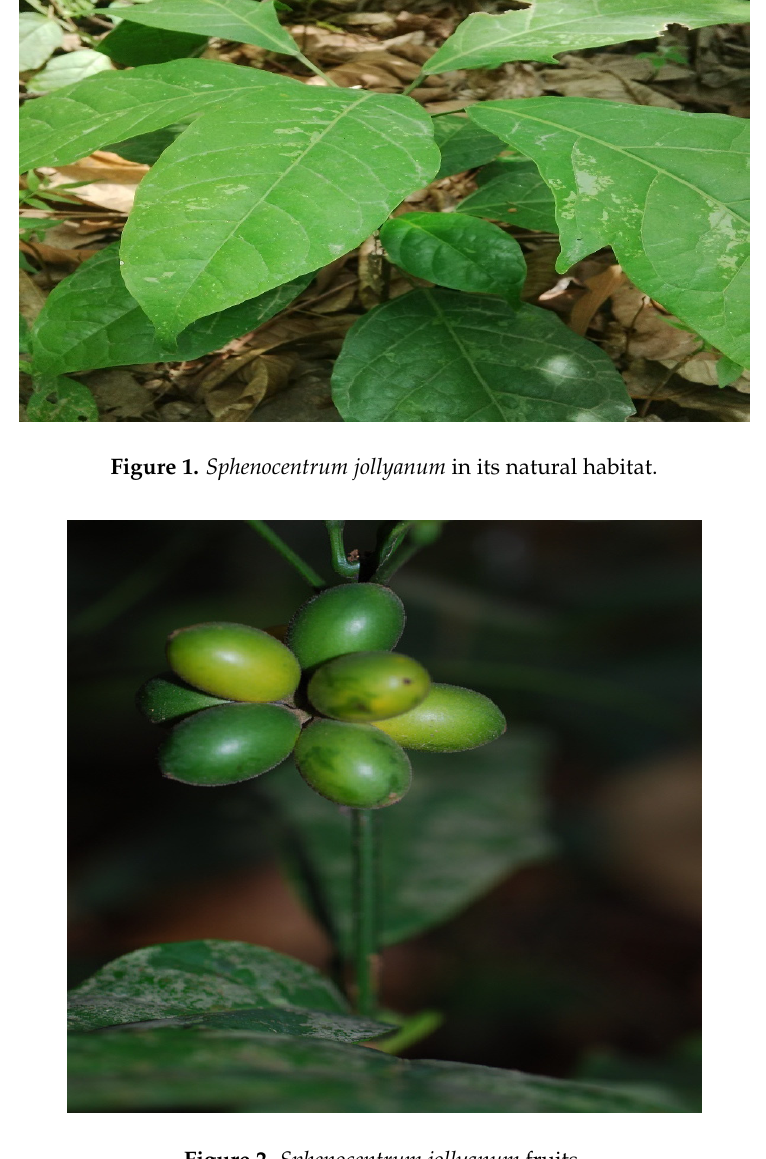
Figure 2. Sphenocentrum jollyanum fruits. Table 1. Taxonomical classification of Sphenocentrum jollyanum [5].